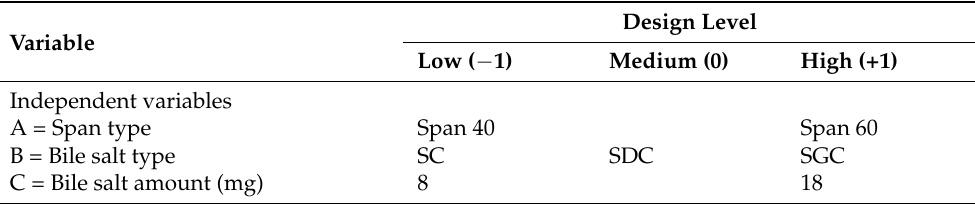
Table 7. Variables and their corresponding levels in the employed 3 1 2 2 multilevel categoric design for DNa-loaded